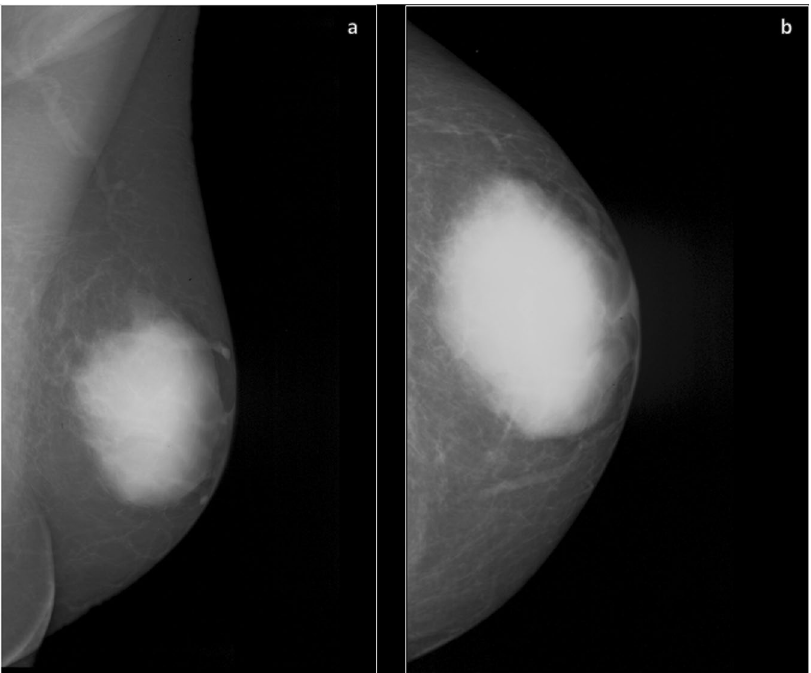
Figure 1. Mammographic findings of a breast plasmacytoma in a 54-year old man. Mammography of the left breast in mediolateral oblique ( a ) and craniocaudal ( b ) views showing a high-density mass with indistinct margins in the central part of the breast.